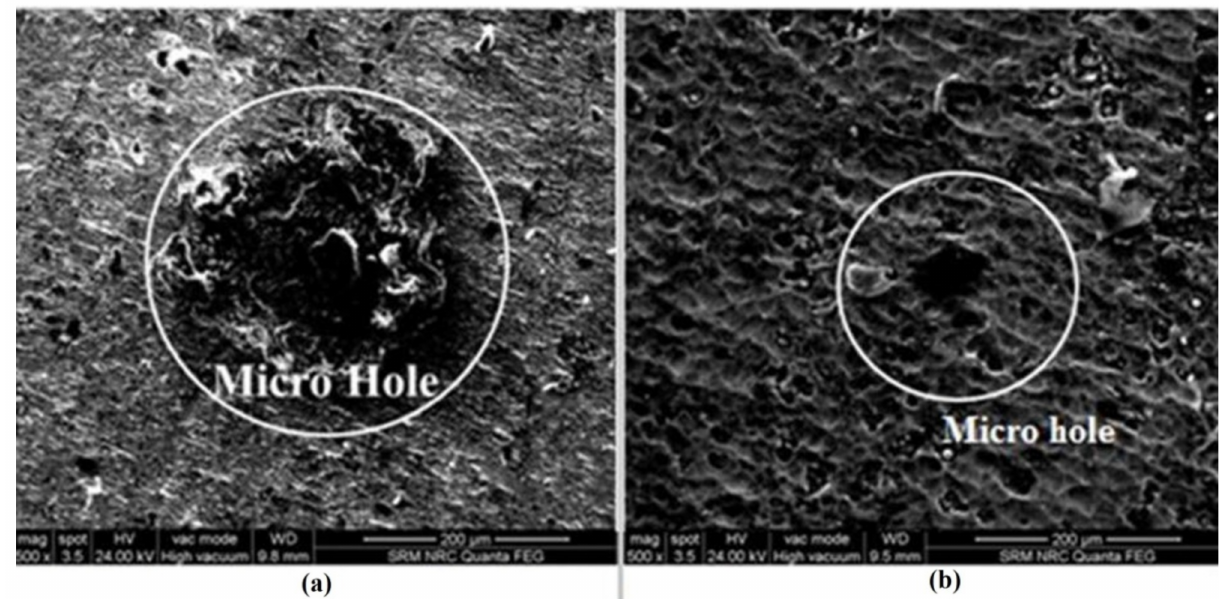
Figure 5. SEM image of machined workpiece surface by additive tool ( a ) 15 V, 1 mol/L Sodium Nitrate, 50% duty cycle ( b ) 15 V, 1 mol/L Sodium Nitrate, 66% duty cycle.